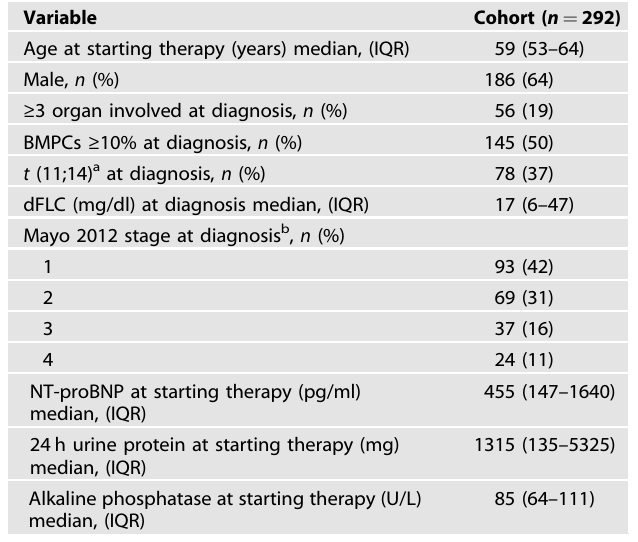
Table 1. Baseline characteristics.